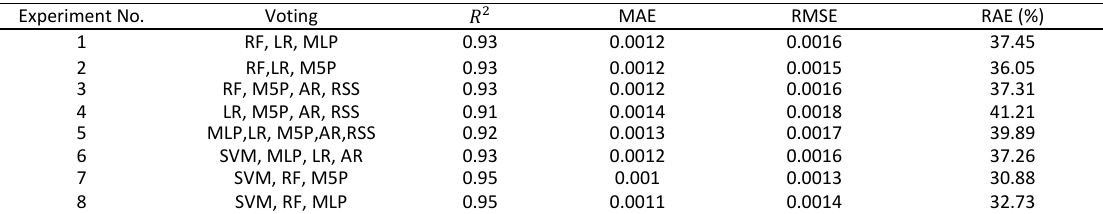
Table 4: Results of different group-I classifiers combined in voting Experiment No.